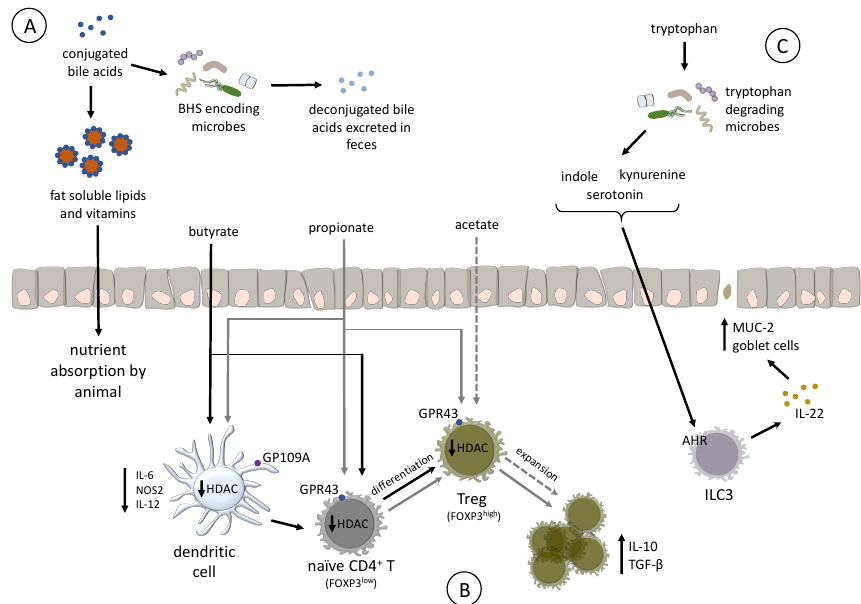
Figure 3. Microbial functions have many e ff ects within the intestinal tract. ( A ) Bile acids (BA) emulsify lipids and vitamins, improving absorption by the host. Bile salt hydrolases produced by members of the microbiota deconjugate BAs, reducing their solubility and increase their excretion in the feces. Loss of BAs inhibits nutrient absorption and reduces BA recycling. ( B ) Short chain fatty acids (SCFA) are bacterial fermentation products that can be an energy source for colonocytes and impact immune cell development. Butyrate and propionate have been shown to inhibit nuclear histone deacetylases (HDAC) in macrophage and CD4 cells, prompting the generation of regulatory T cells (Treg). These Treg cells modulate the immune system, maintaining self-tolerance; suppression of allergy-, asthma- and pathogen-induced immunopathology; etc. Each unique arrow (back, gray, or dashed) from each SCFA, shows the respective downstream e ff ects of each SCFA. ( C ) Tryptophan can be degraded by microbes into a variety of intermediates including indole and serotonin. These molecules are endogenous ligands for the aryl hydrocarbon receptor (AHR) that is present on multiple adaptive and innate immune cells. When AHR is signaled in interepithelial type 3 innate lymphoid cells, these cells produce IL-22. This cytoprotective cytokine supports the acts to strengthen epithelial barrier functions by inducing the secretion of antimicrobial peptides from epithelial cells, production of mucins (MUC-2), and proliferation of intestinal goblet